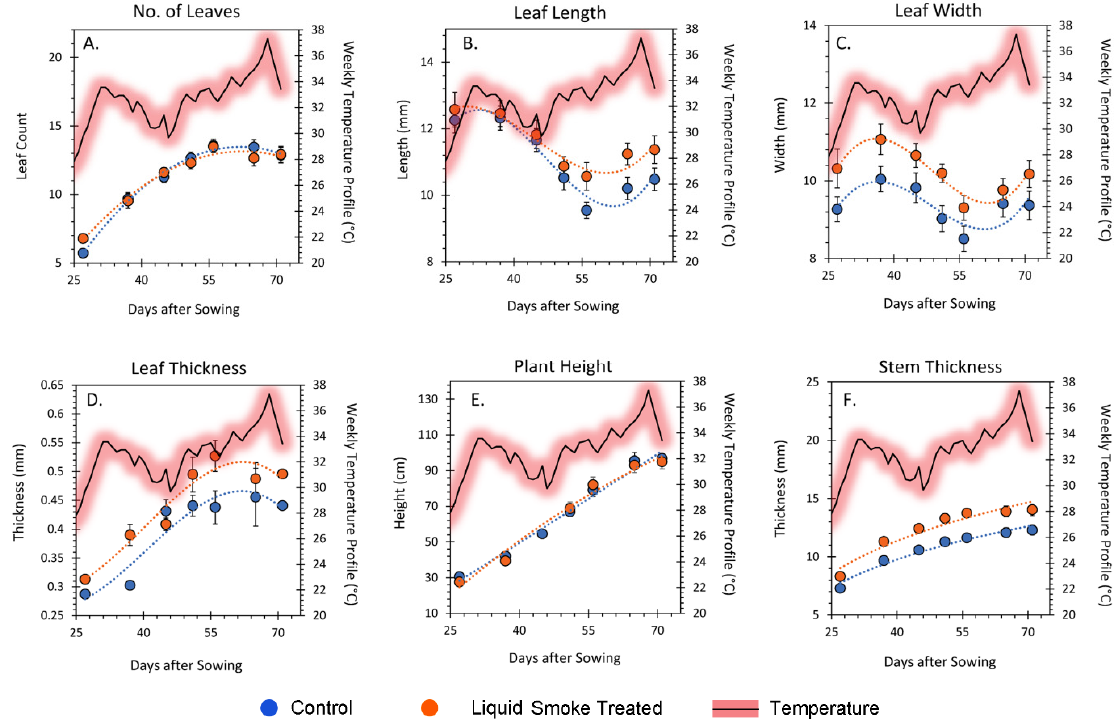
Figure 7. Plant growth performance for outdoor potted plants. Panel ( A ): total number of plant leaves were tallied weekly for liquid smoke treated and untreated control plants. Panel ( B – D ): upper most fully expanded source leaf dimensions were measured in millimeters (mm) which included leaf length, leaf width and leaf thickness. Panel ( E ): plant height was measured in centimeters (cm) and monitored weekly. Panel ( F ): stem thickness was measured in millimeters (mm). Each data point represents an average value ± SE for control, N = 22 plants and liquid smoke-treated, N = 23 plants. Data were fit to best trends shown in each panel as the dashed lines. Furthermore, each panel shows the temperature trend that was recorded over the growing season for the 5-day average of temperature highs.